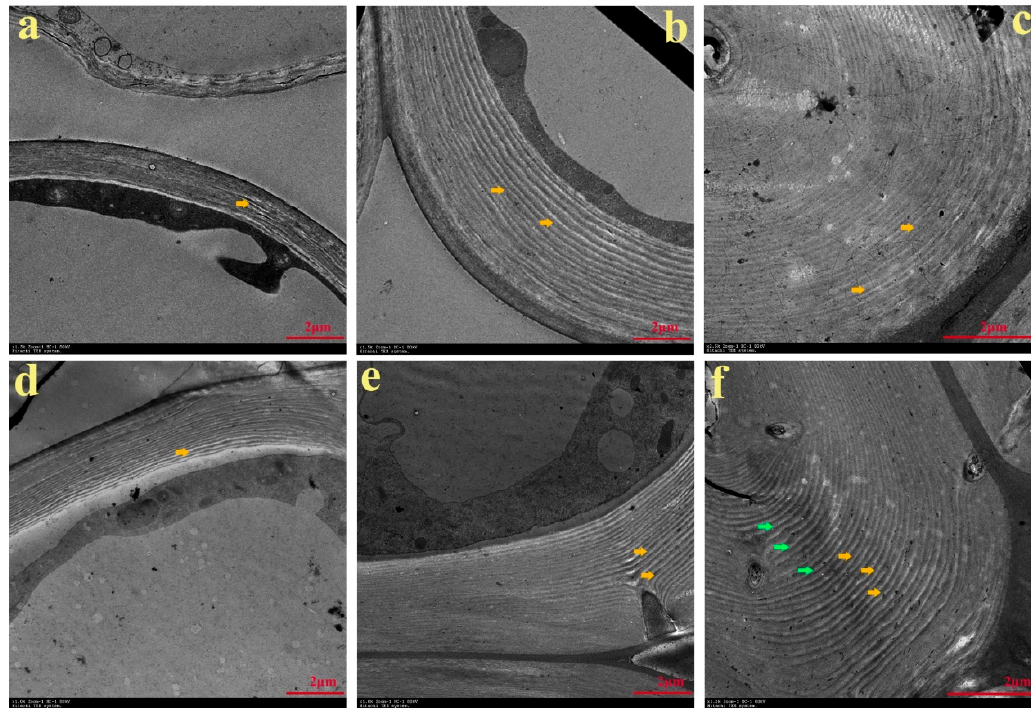
Figure 3. Structure of the secondary cell wall of stone cells in CL and YL fruits: ( a – c ): The SCW structure of stone cells in CL fruits at the early, middle and mature stages; ( d – f ): The SCW structure of stone cells in YL fruits at the early, middle and mature stages. Dyeing with potassium permanganate can make lignin appear dark under electron microscopy. The orange arrows indicate the dark streaks formed by the deposition of lignin. The green arrows indicate the bright streaks formed by the deposition of cellulose microfibrils.